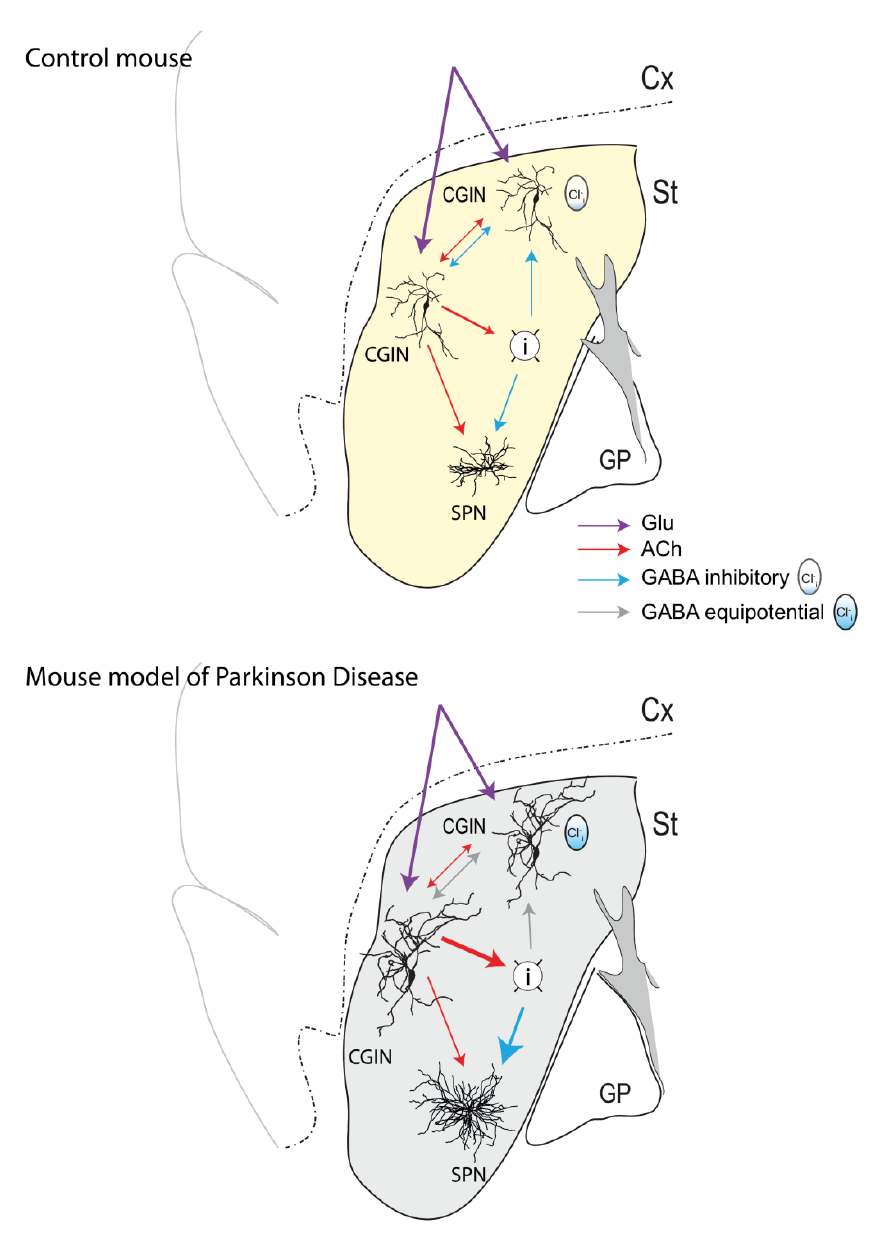
FIGURE 1: Schematic drawing of a mouse brain sagittal section show- ing sensory motor cortex (Cx), dorsal striatum (St), and Globus Pallidus (GP). Yellow indicates control dopaminergic innervation (top) whereas gray indicates deple- tion of dopaminergic terminals (bottom). Connections between CGINs, GABAergic Interneurons (I) and Spiny Projections Neurons (SPN) with different colors as indi- cated. Polarity of GABA actions depend on the intracellular chlo- ride levels as illustrated